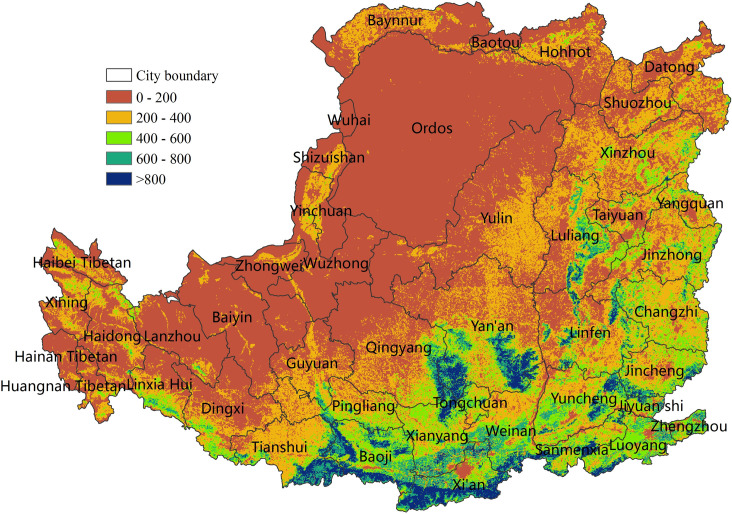
Average NPP (g C/m2) of the Loess Plateau from 2000 to 2015.